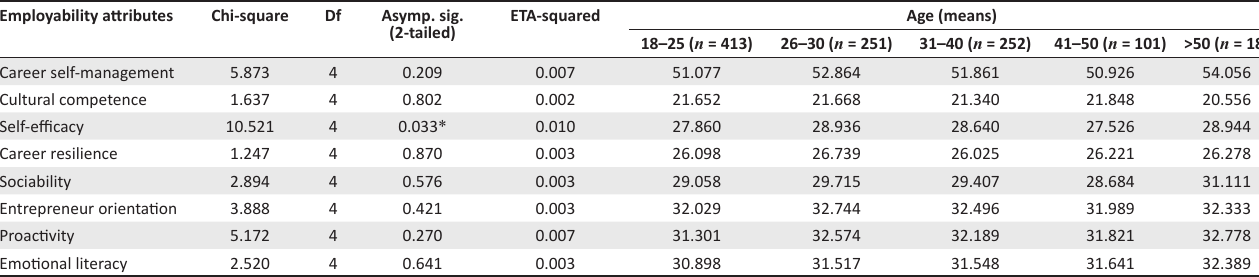
TABLE 4: Differences in employability attributes with regard to age. Employability attributes